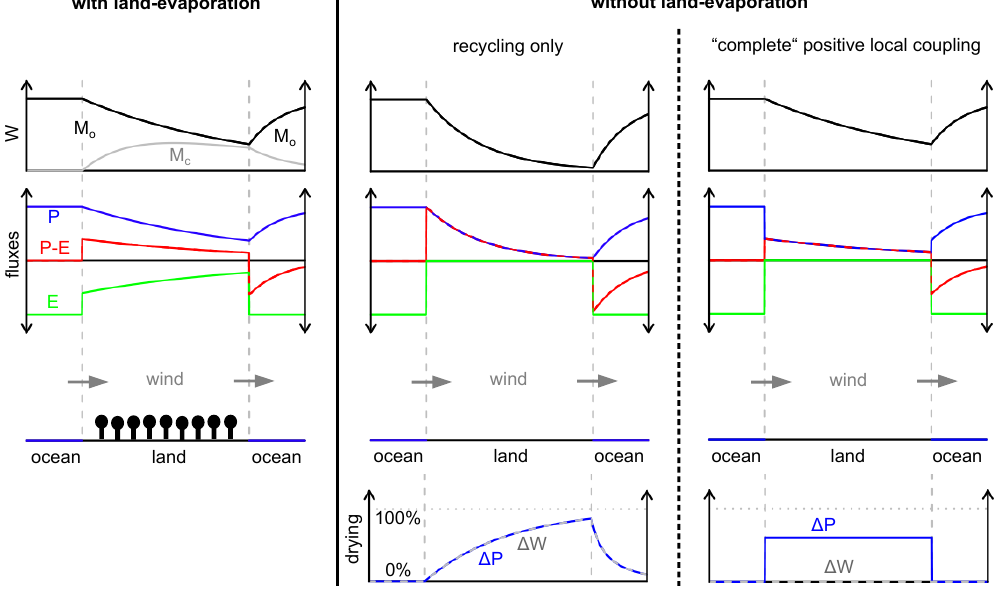
Fig. 8. Illustration of two principally possible idealised responses to the suppression of land-evaporation as 1-D-transects through a con- tinent. Left panel: reference situation with continental evaporation. Middle panel: response to the suppression of continental evaporation dominated by moisture-recycling. Right: response to the suppression of continental evaporation in a special case: The decrease in precipi- tation completely compensates for the missing evaporation, such that P − E is unaffected. W =precipitable water, M o =oceanic moisture, M c =continentally recycled moisture, P =precipitation, E =evaporation. The graphs at the bottom show the relative reduction ( REF − DRY of P (blue, solid) and W (grey, dashed). Units are